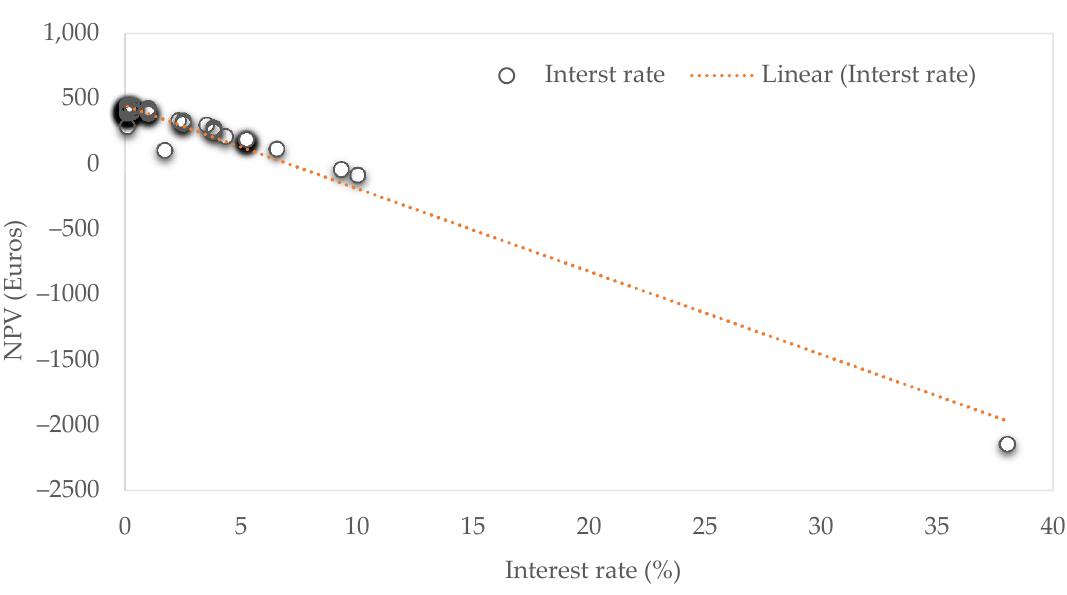
Figure 26. NPV profit increase with financing model 2.